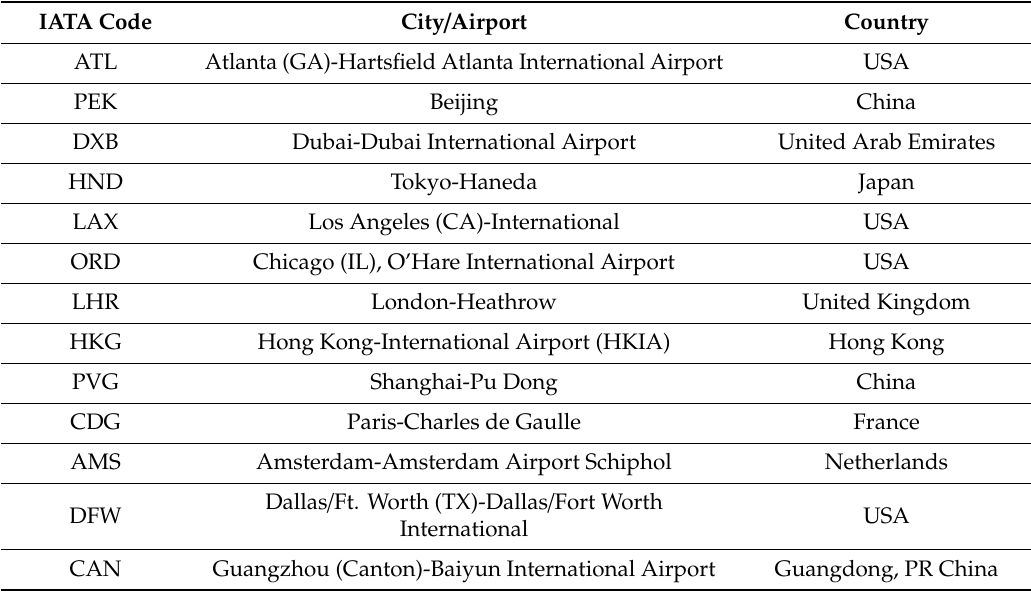
Table A1. List of airports used in the T50